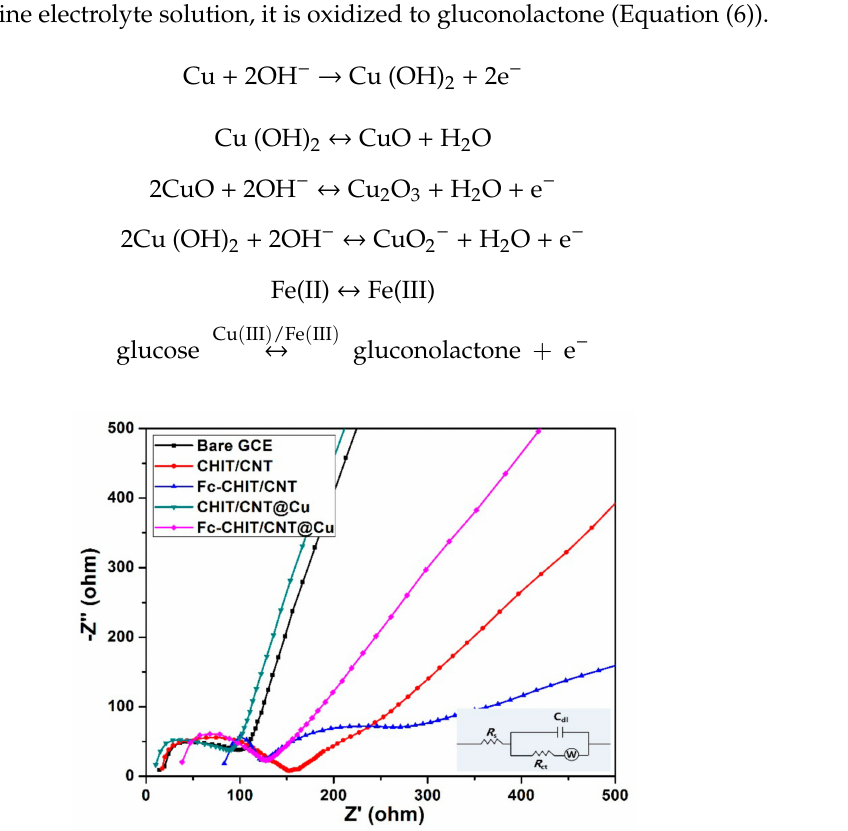
Figure 4. Nyquist plots for bare GCE, CHIT / CNT, CHIT / CNT@Cu, Fc-CHIT / CNT and Fc-CHIT / CNT@Cu (inset is an equivalent circuit model). Electrolyte: 5.0 mM Fe(CN) 63 − / Fe(CN) 64 − containing 0.1 M